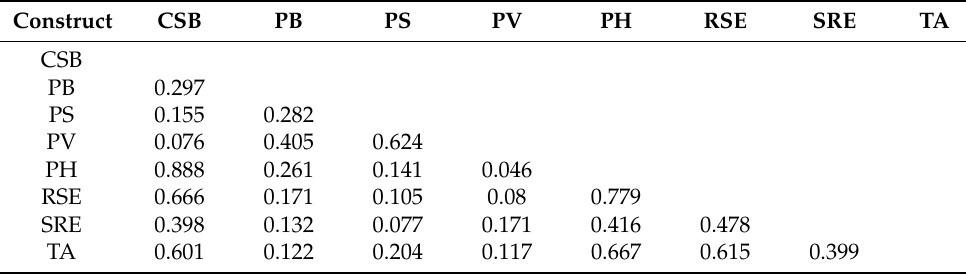
Table 4. Heterotrait-Monotrait Ratio of Correlations